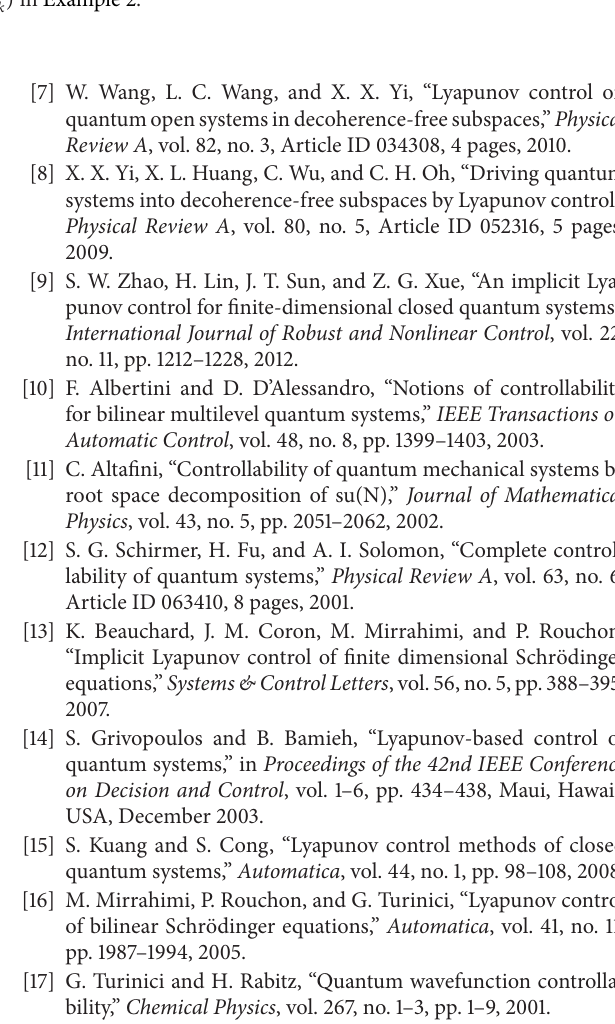
Figure 2: (a) The population of the five-level system trajectory from |𝜓 0 ⟩ by control fields 𝑓 1 (𝑡) and 𝑓 2 (𝜏 𝑘 ) in Example 2; (b) the population of the five-level system trajectory from |𝜓 0 ⟩ without control field 𝑓 2 (𝜏 𝑘 ) in Example